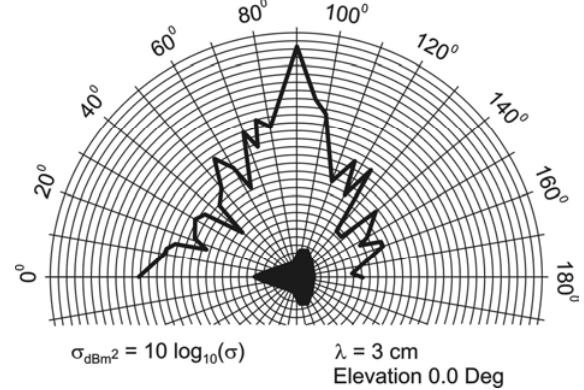
Fig 13. Predicted signature of a generic aircraft illuminated by 3 cm wavelength radar. Includes surface reflections and edge diffraction but excludes corners, tips, and double reflections. From the front up to the azimuth 30 o , the box type air intakes totally dominate the signature. More than 60% of RCS at 65 o is due to the wing leading edge. After R. Whitford [34]